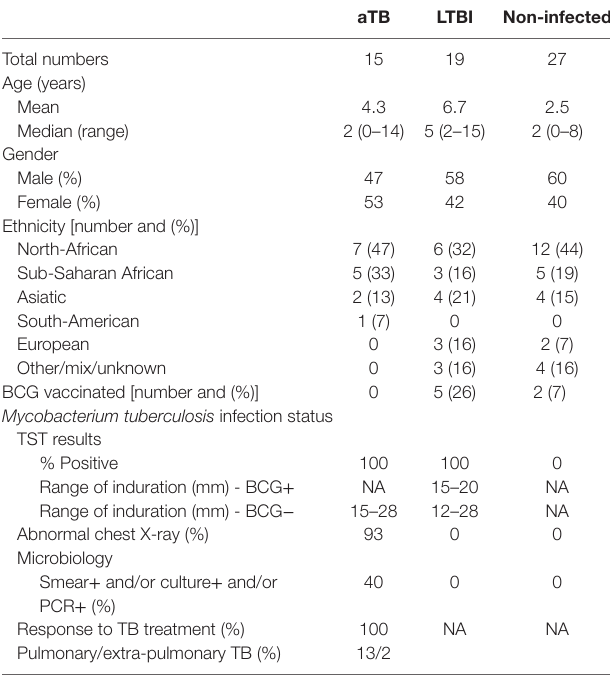
Table 1 | Demographic and clinical data.